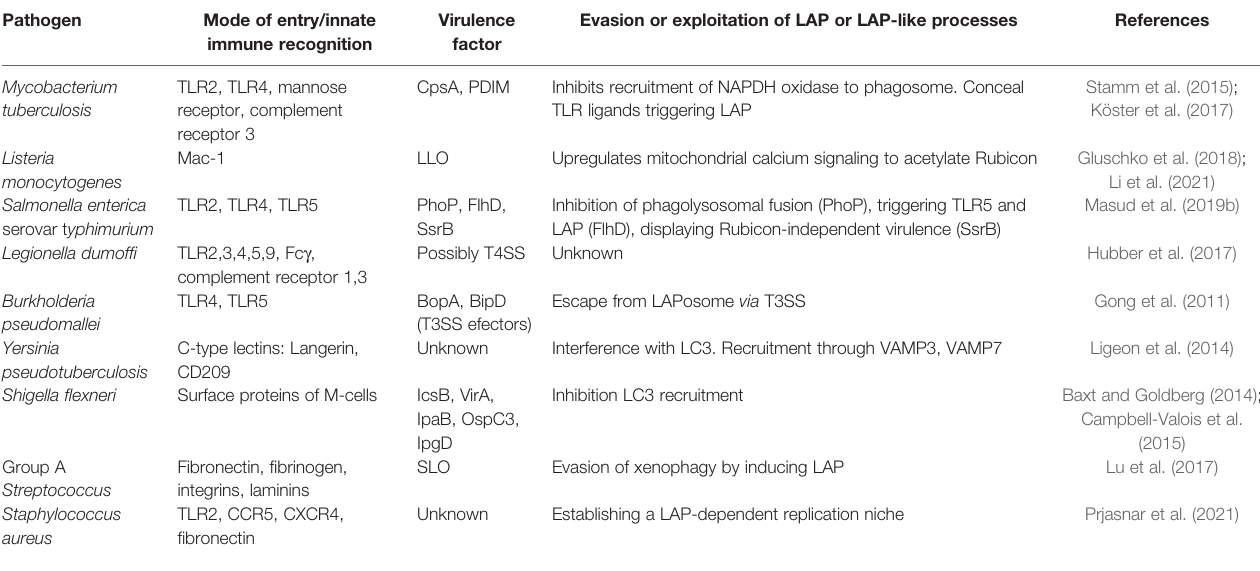
TABLE 1 | Overview of LAP-targeted bacterial pathogens and their evasion strategies.